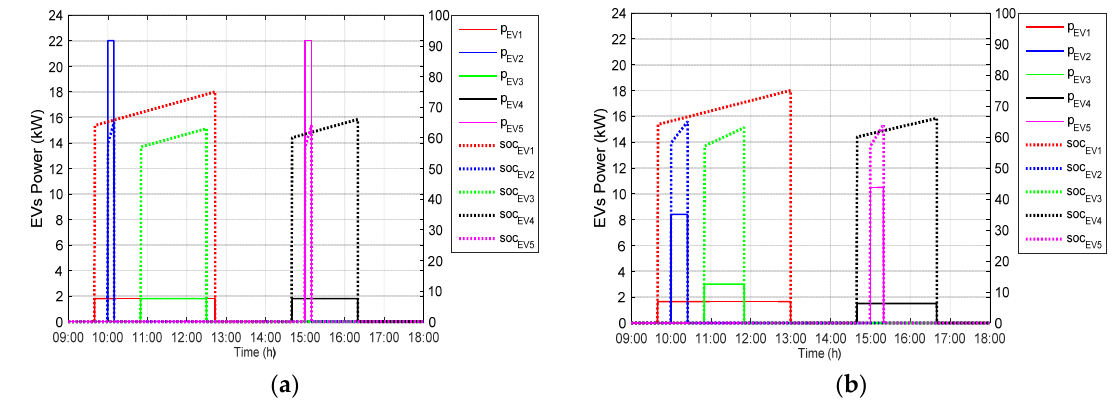
Figure 21. ( a ) EVs charging power and EVs SOC evolution for Scenario 2c; ( b ) EVs charging power and EVs SOC evolution for Scenario 2d.